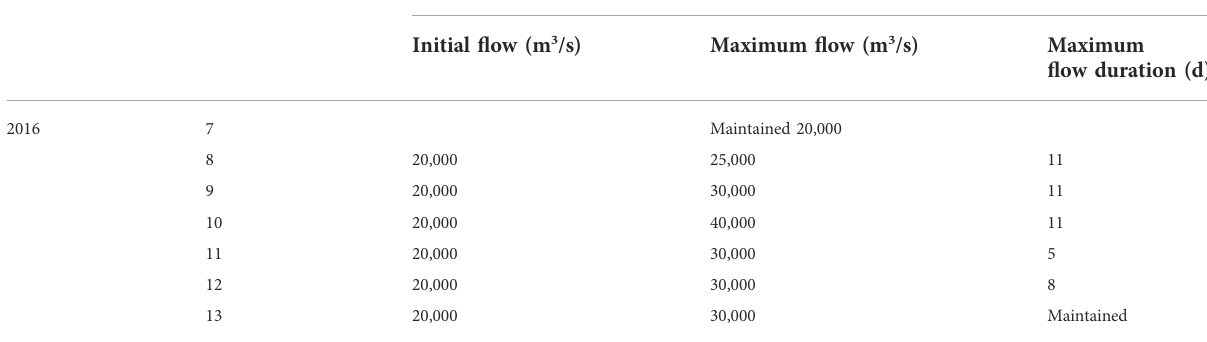
TABLE 4 Upper boundary settings of different increasing discharge schemes from the TGR.